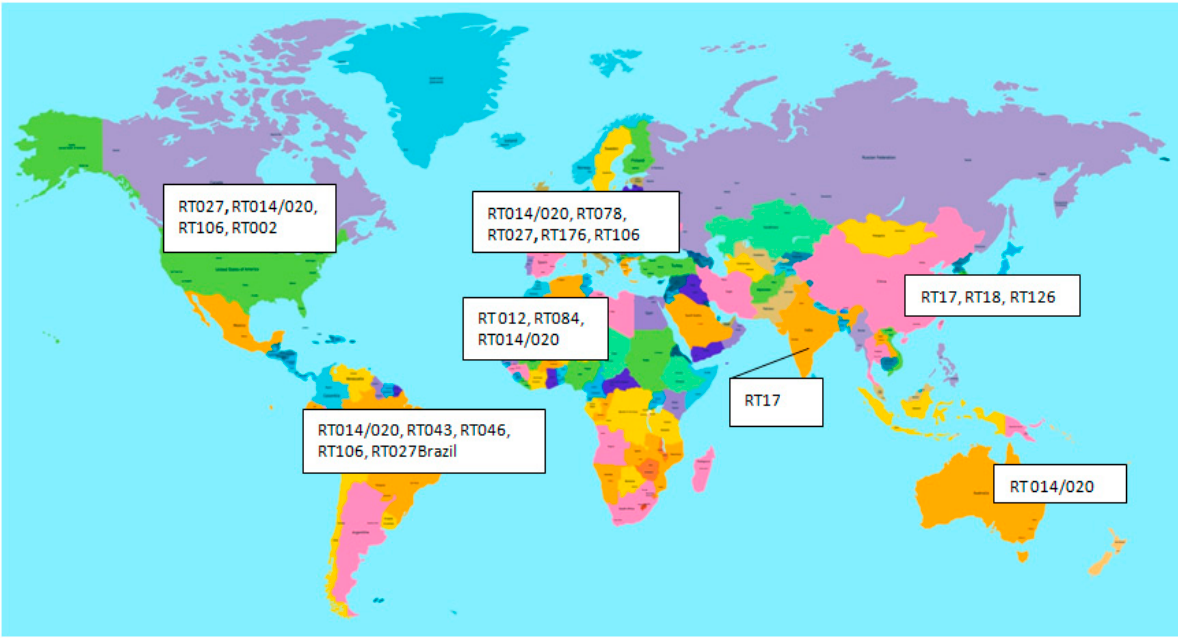
Figure 2. Distribution of some important C. difficile ribotypes in different continents [17,57–66]. The recurrence of the disease was also high—with 20–25% of the cases [10]. The level of recurrence (re-infection of relapse) has also increased in recent years, up to around 30%